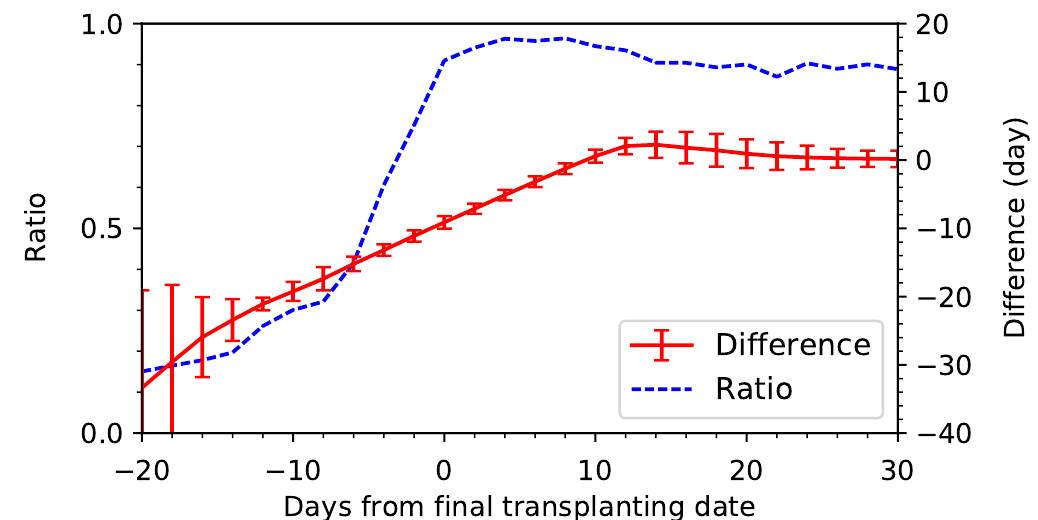
Figure 8. Di ff erence between the preliminary and final estimations (first crop in the dry season of 2019). The solid line shows the average of the preliminary estimation error (Preliminary estimation–Final estimation), and the error bar shows the standard deviation. Here, only fields in which the field average signal intensity exceeds the threshold (128 dB) were selected. The dashed line indicates the percentage of the selected